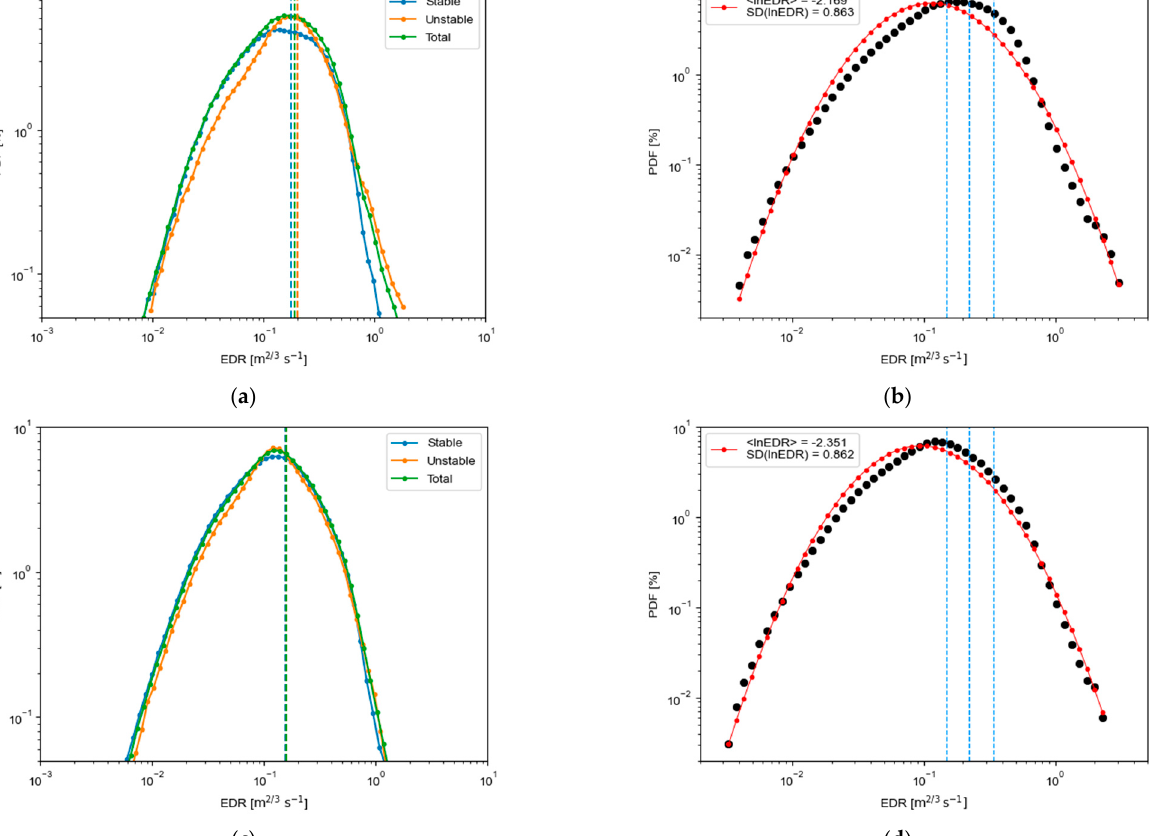
Figure 9. ( a ) PDFs of the EDR for (blue) stable and (orange) unstable planetary boundary layers (PBL), (green) PDF of the EDR regardless of the atmospheric stability, and ( b ) (red line) the best-fit lognormal curve for (black dots) the observed PDF of the EDR where the black dots correspond to the green line in ( a ). ( c ) Same as ( a ) but double rotation was applied, and ( d ) same as ( b ) but double rotation was applied. Atmospheric stability in ( a ) was classified by using the Obukhov length defined in Equation (11). Blue vertical lines in ( b ) show the thresholds of EDR values, 0.15 m 2/3 s − 1 , 0.22 m 2/3 s − 1 , and 0.33 m 2/3 s − 1 , which correspond to the light (LGT), moderate (MOD), and severe (SEV) turbulence intensities for mid-size aircraft like B-737.